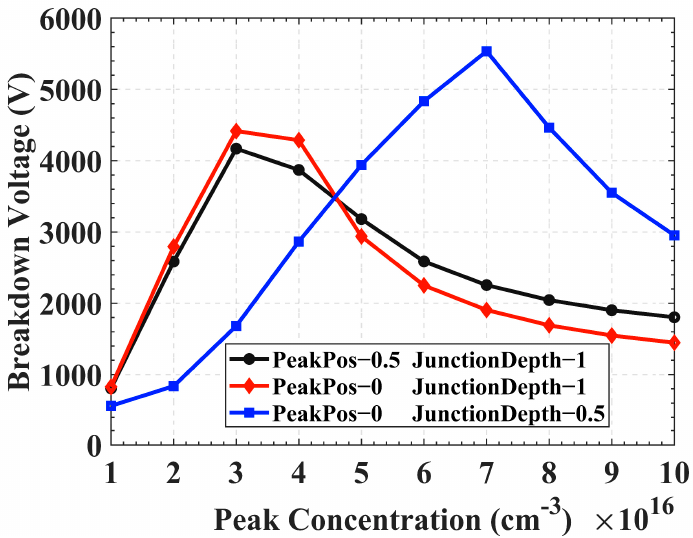
Figure 5. Influence of floating ring process parameters on breakdown voltage.